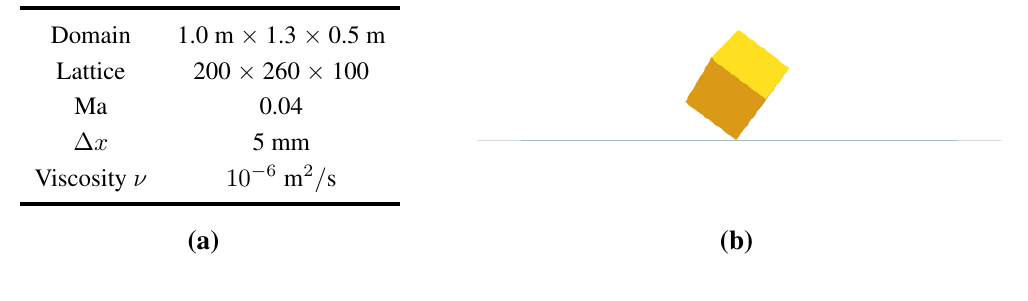
Figure 12. Freely falling cube: parameters and initial configuration. ( a ) Parameters; ( b ) initial condition.